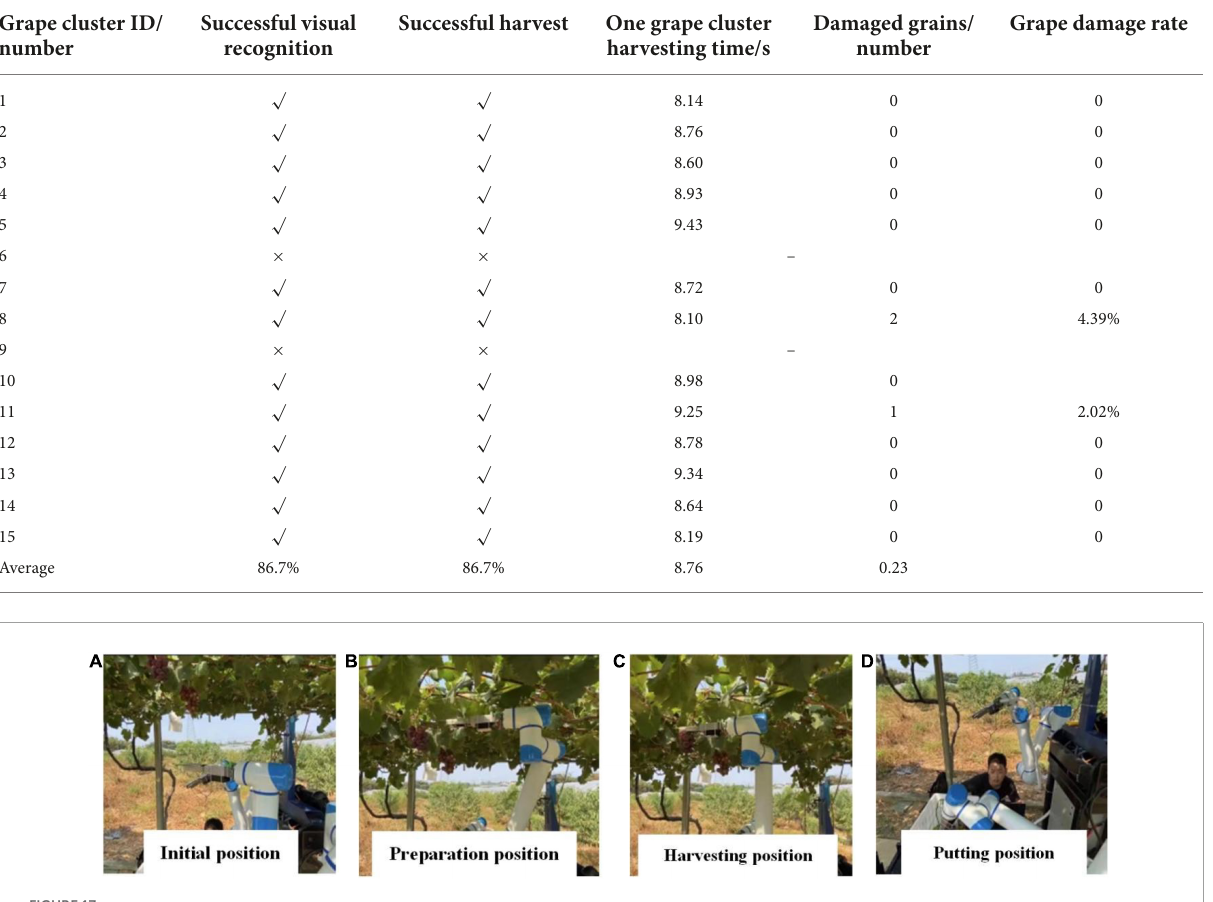
TABLE 3 Trellis performance experiment results. Grape cluster ID/ number